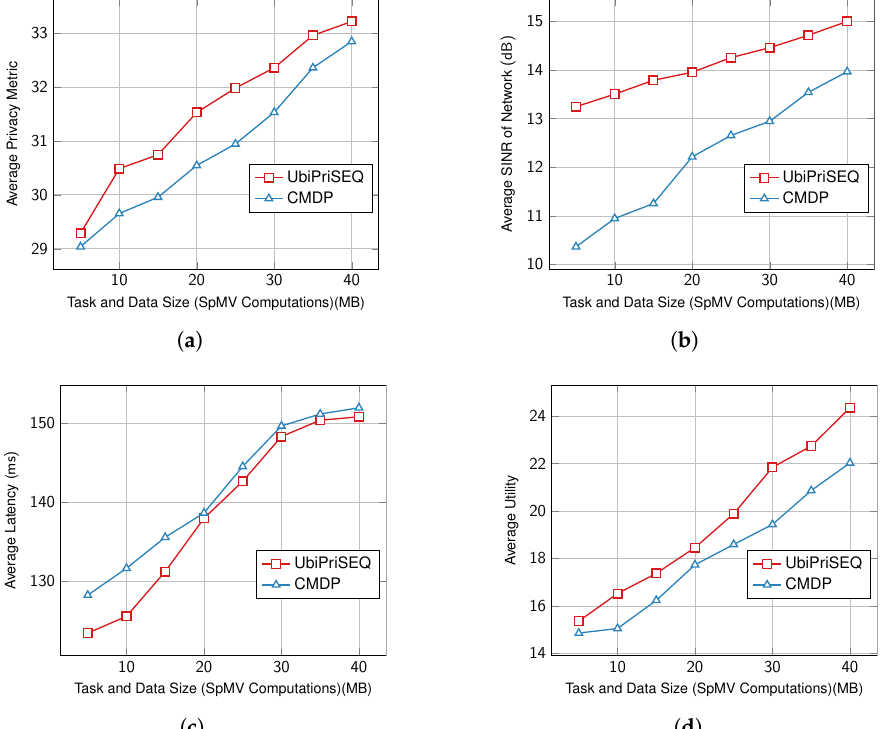
Figure 4. UbiPriSEQ: Performance vs. Task and Data Sizes ( a ) PrivacyMetric, ( b ) SINR, ( c ) Latency, ( d )